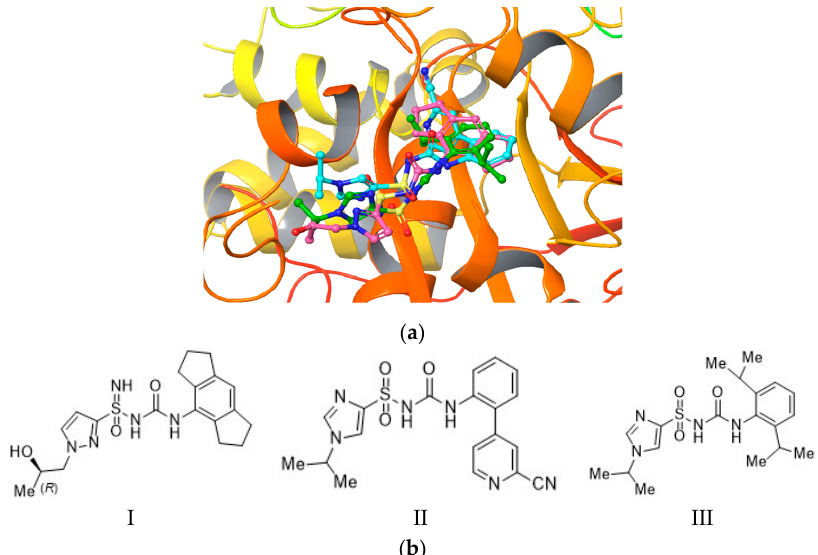
Figure 5. ( a ) Binding pose of compounds I , II , and III docked into the centered Walker B region; ( b ) compounds I , II , and III 2D